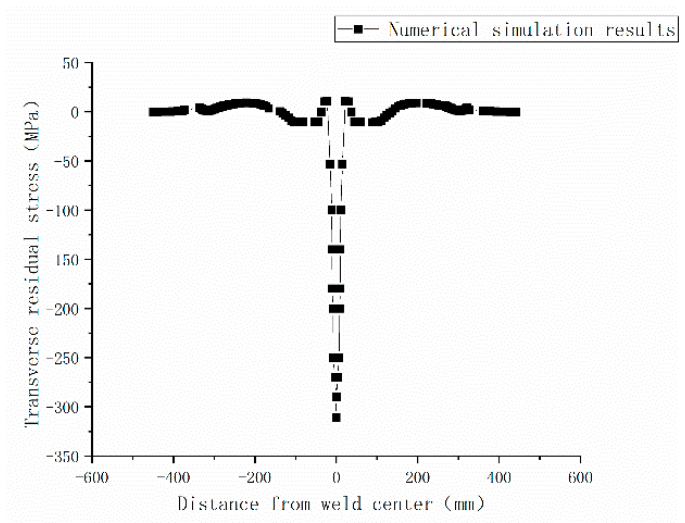
Figure 18. Transverse residual stress along the vertical weld path on the outer surface of the spherical pressure hull.